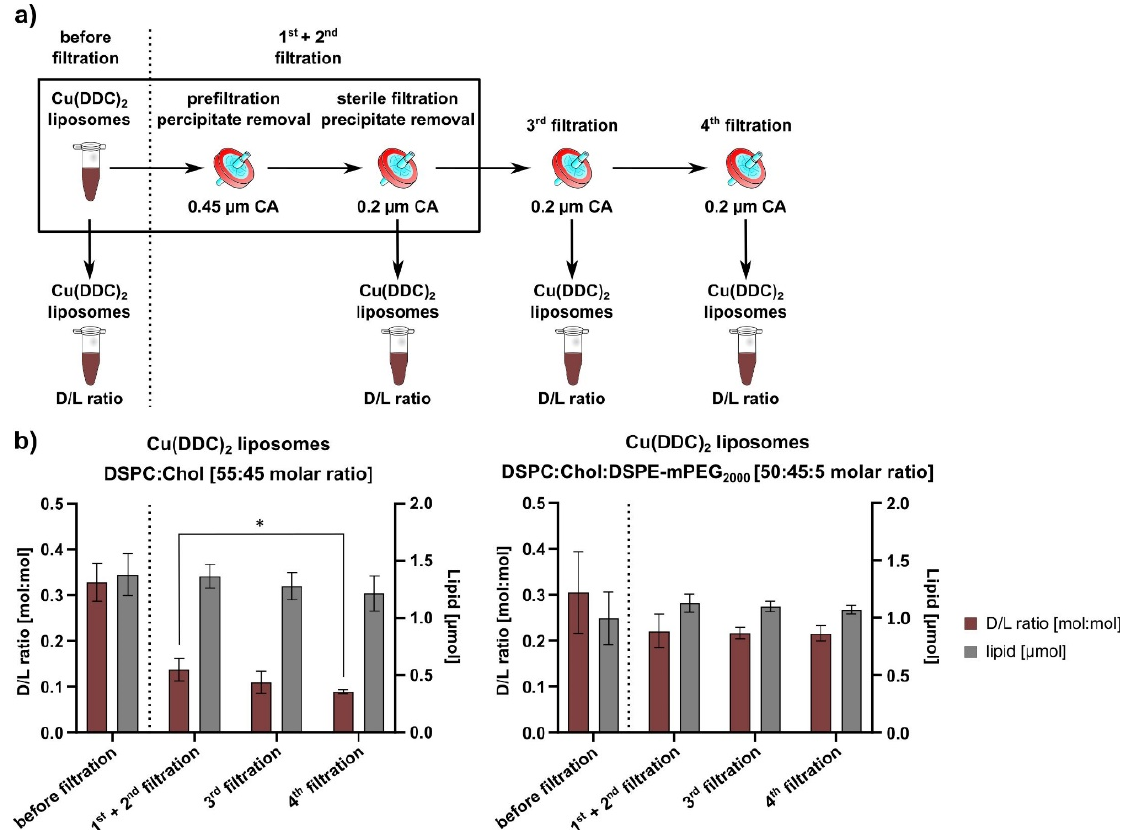
Figure 2. Validation analysis of the removal of extraliposomal Cu(DDC) 2 via surface area filtration. ( a ) Experimental procedure of testing consecutive filtration steps for the removal of extraliposomal Cu(DDC) 2 . The 1 st + 2 nd filtration was part of the liposome preparation process. The 3 rd and 4 th filtration were conducted to determine the limit of filtration steps until affecting liposomal stability. Aliquots were collected after each step to determine the D/L ratio and lipid amount. ( b ) The D/L ratio and lipid amount of non-PEGylated and PEGylated liposomes were analyzed after consecutive filtration steps and evaluated statistically via one-way ANOVA and Tukey’s multiple comparison test (* p = 0.0104). Data are expressed as the mean ± SD ( n = 3–4). Table 1. Hydrodynamic diameter (d h ), polydispersity index (PDI), and D/L ratio of prepared liposomes. Data are expressed as the mean ± SD ( n =